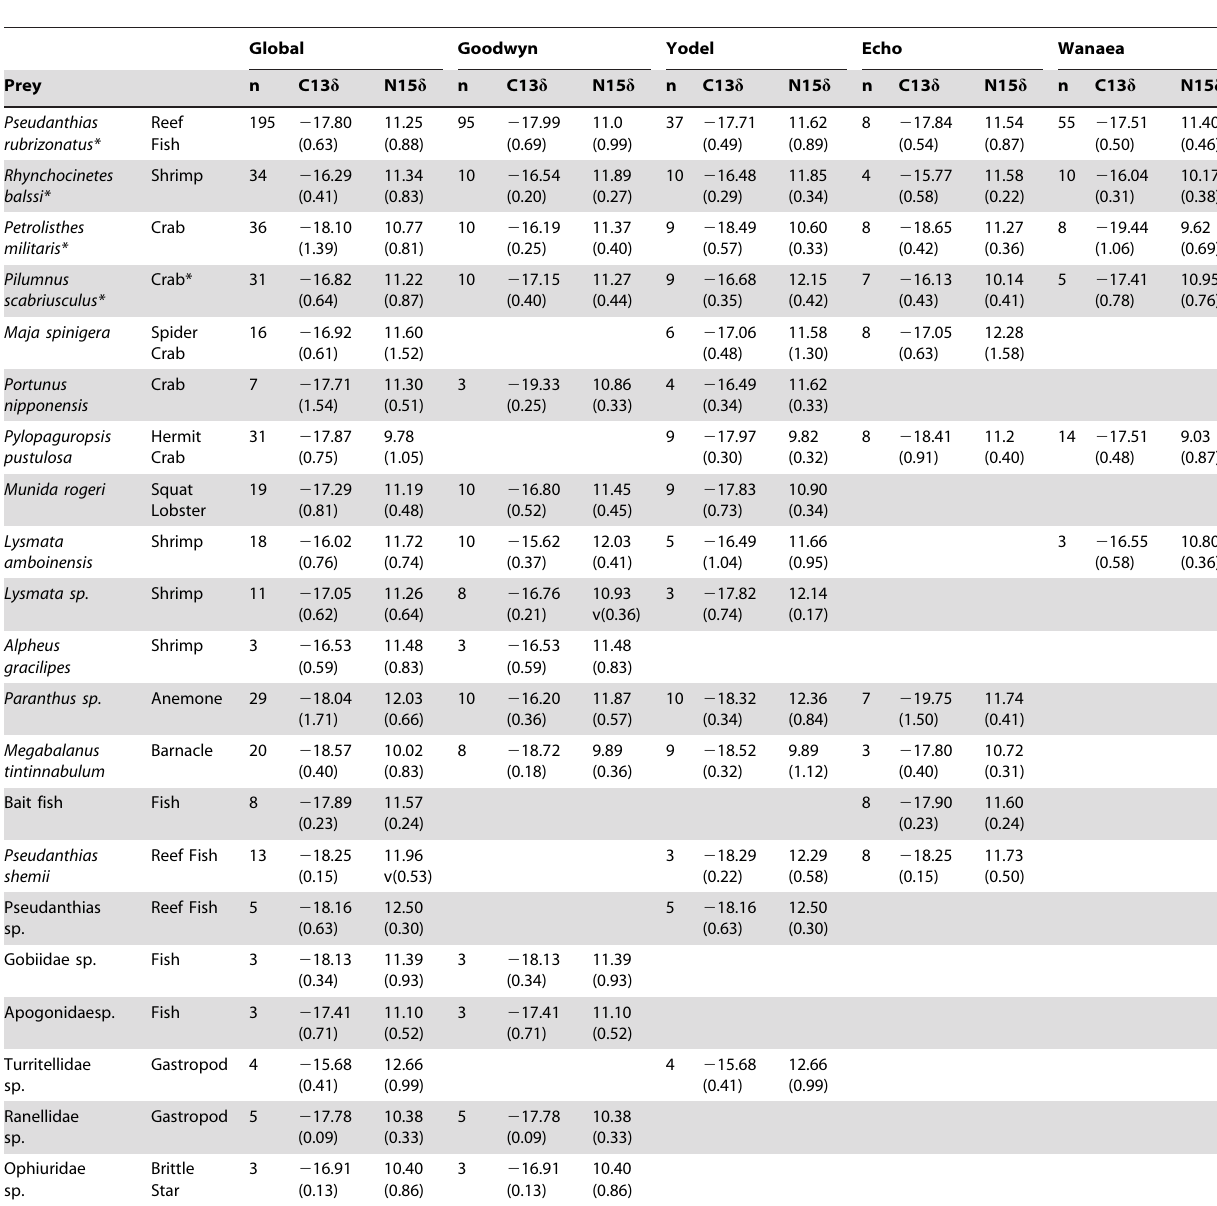
Table 2. Values of d 13C and d 15N (mean and standard deviation) for the prey species collected from each site.